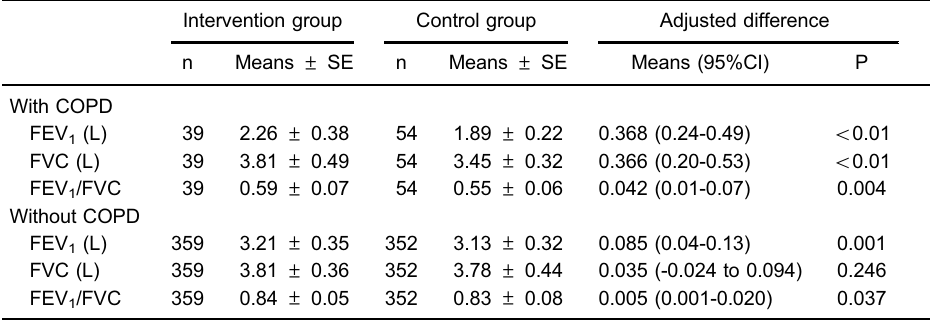
Table 5. Comparisons of lung function in the intervention and control groups after 18 years